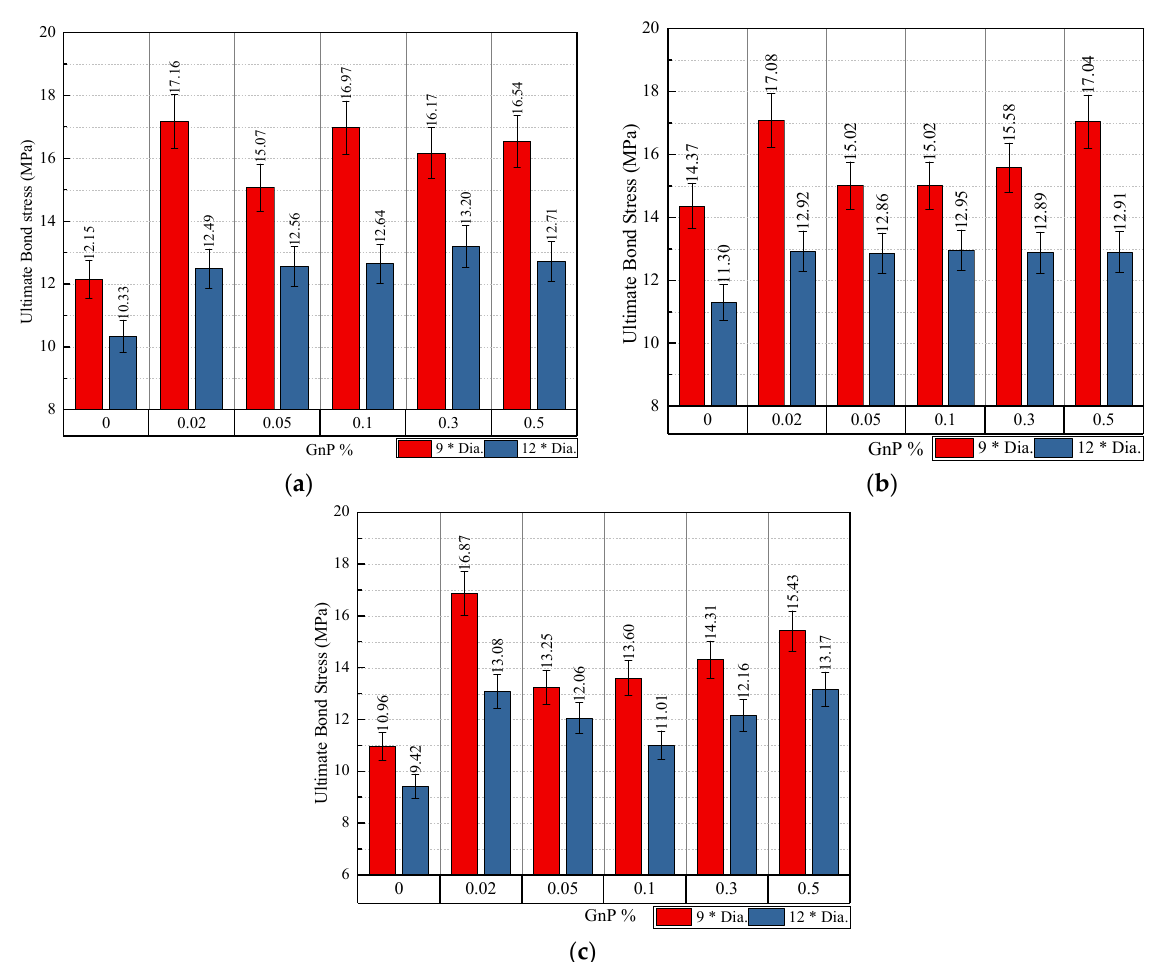
Figure 12. Impact of embedded length on ultimate bond stress for specimens with bar diameter: ( a ) 10 mm; ( b ) 12 mm; ( c ) 16 mm.